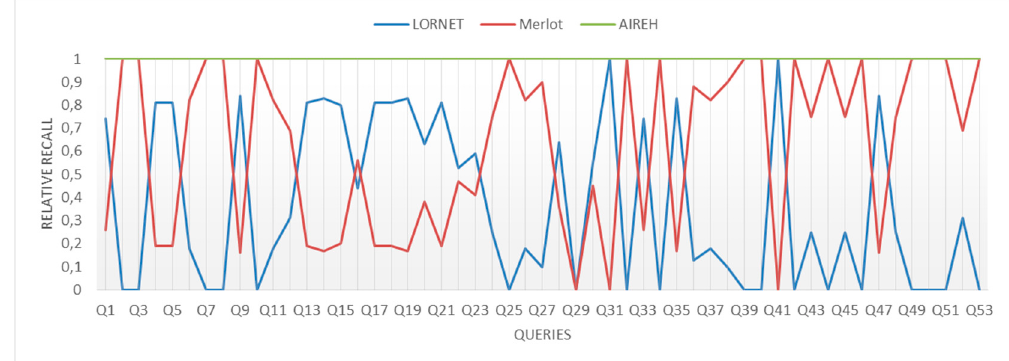
Figure 10. Relative recall comparative.